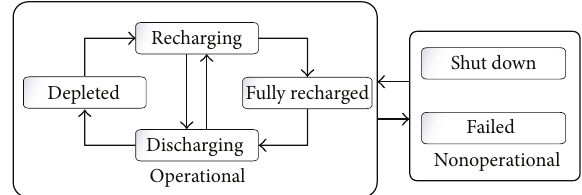
Figure 4: Statechart of the HRES energy storage system.